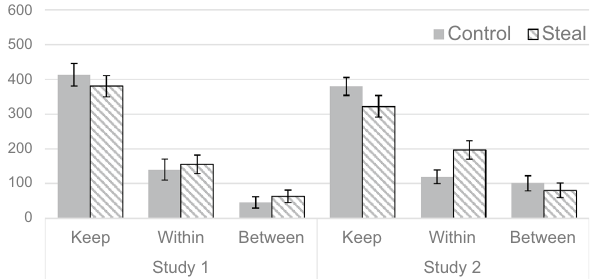
Figure 1. Mean keep or invest amounts for each condition (error bars represent standard